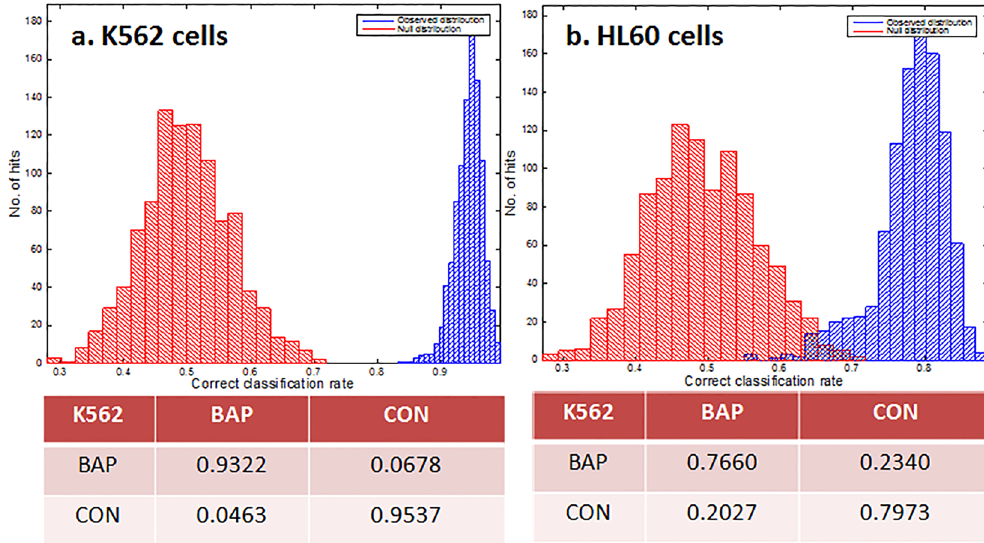
Figure 3. Classification model for PLS-DA of S-FTIR analysis of whole cell populations for K562 ( a ) and HL60 ( b ) cells showing classification rates for real (blue) and random (red), with a CCR of 1 being a 100% correct classification. The embedded tables are the average confusion matrices with rows representing predicted classification and columns representing experimental.